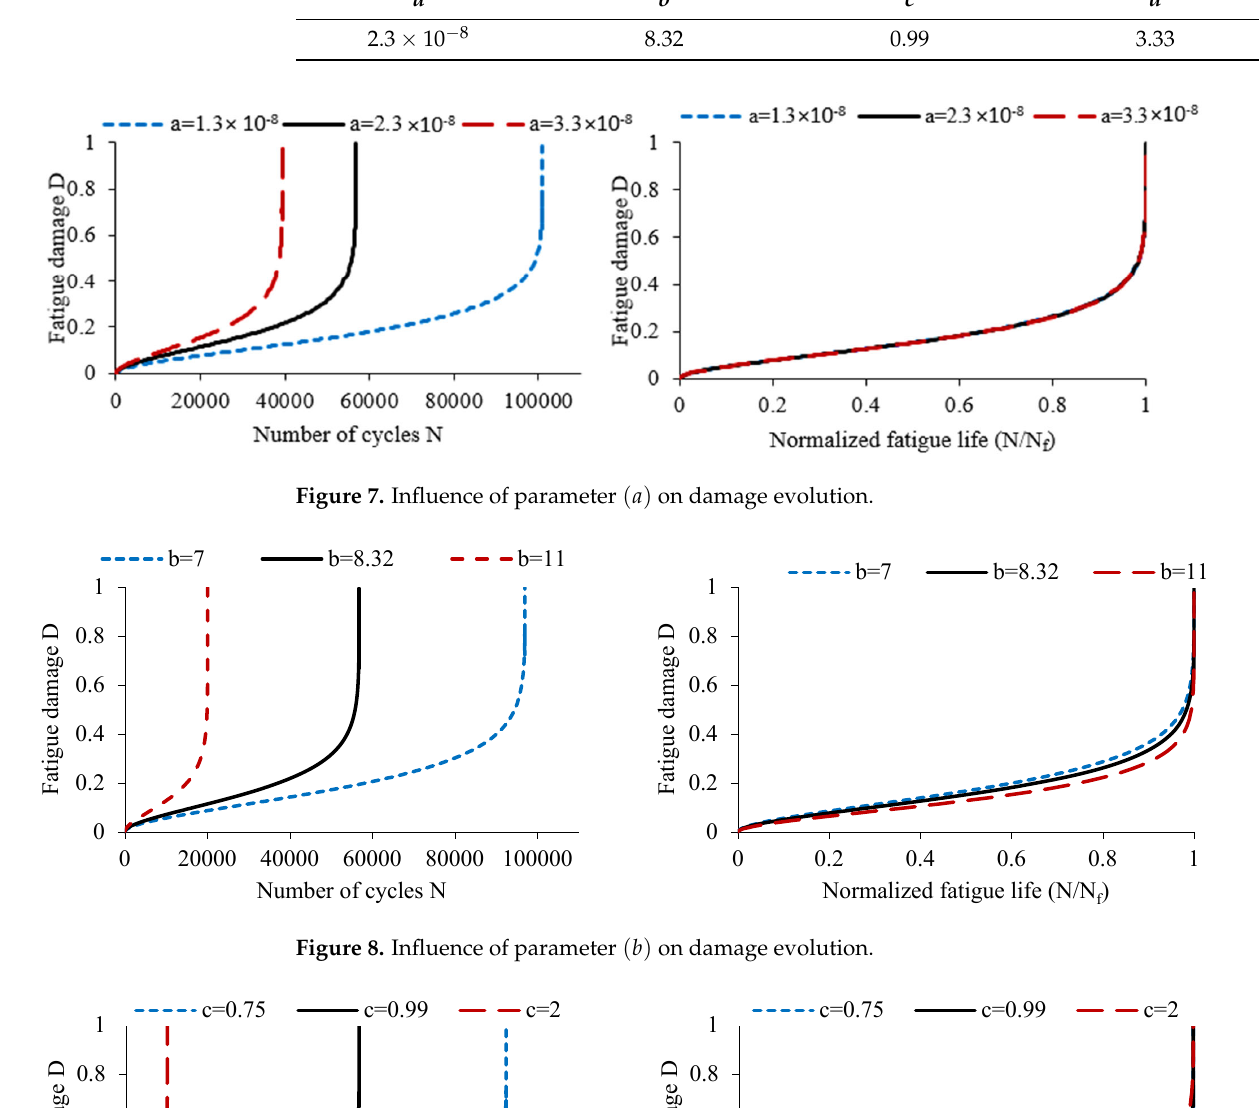
Table 4. Initial values of damage fatigue model parameters.